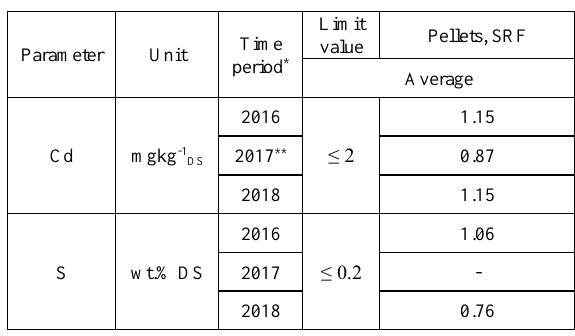
Table 14. Additional regulated SRF quality parameters in Slovenia